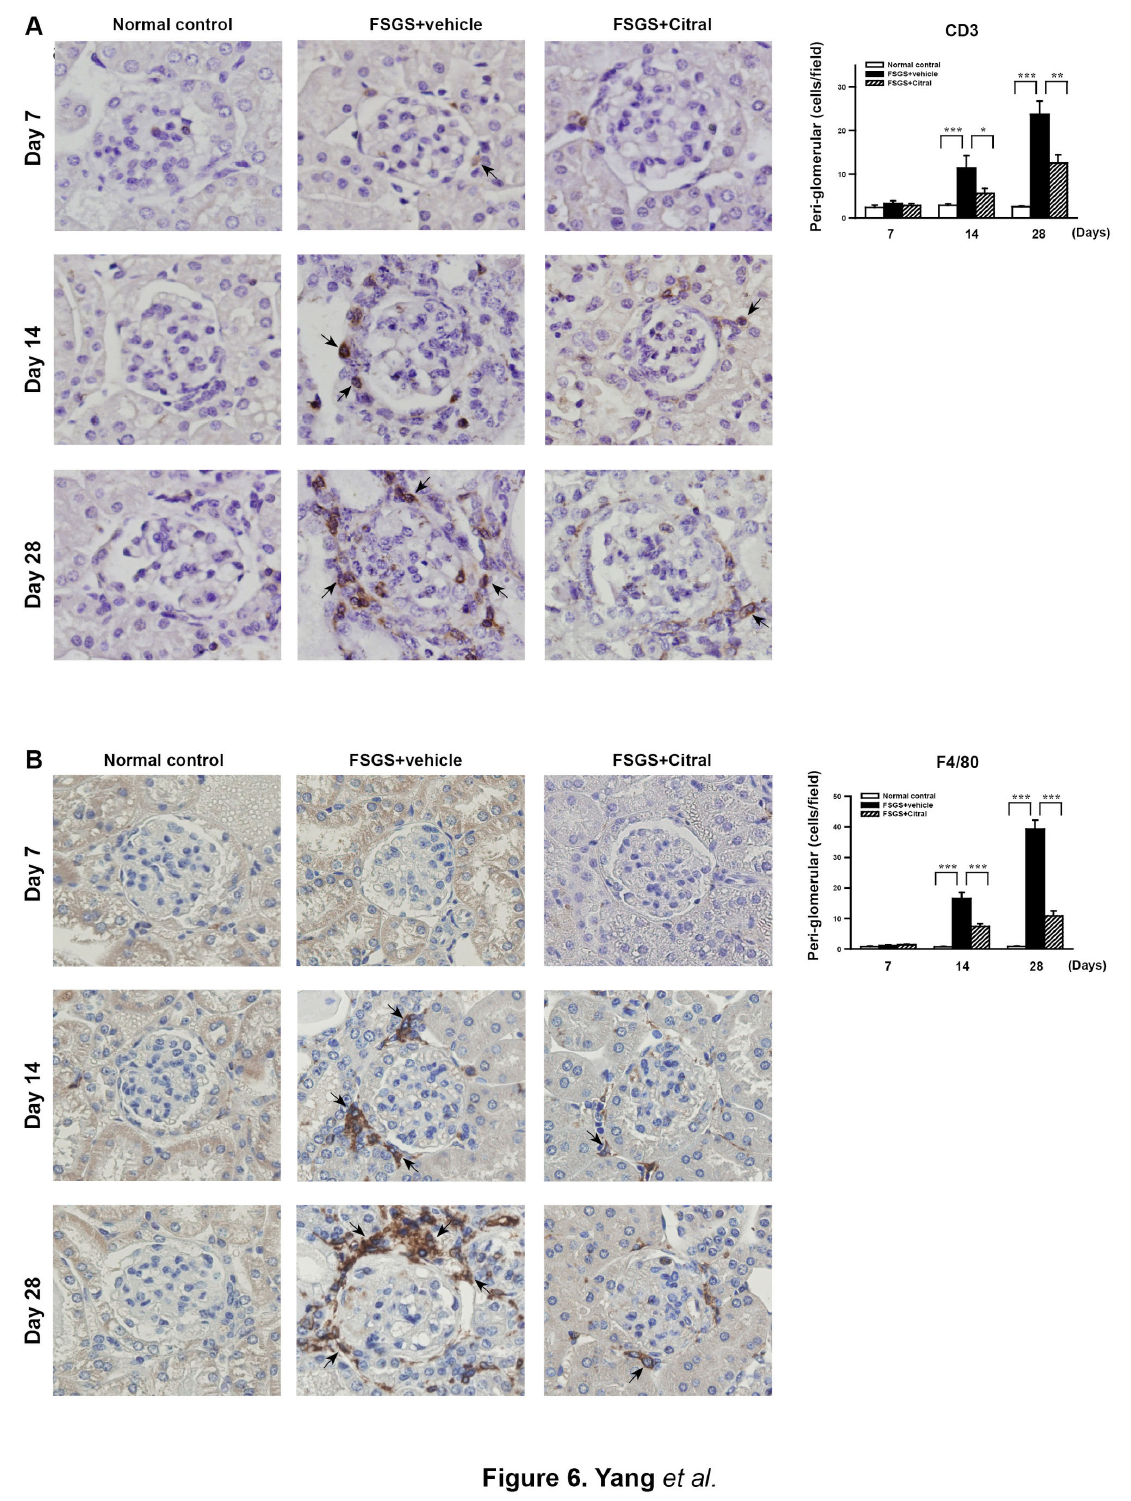
Figure 6. Renal T cell and macrophage infiltration. Detection of (A) CD3 + T cells or (B) F4/80 + monocytes/macrophages by immunohistochemical staining. The arrows indicate positively stained cells. Original magnification, 400×. The scoring is shown on the right. The data are the mean±SEM for seven mice per group. * p < 0.05, ** p < 0.01, *** p < 0.005. doi: 10.1371/journal.pone.0074871.g006 PLOS ONE |